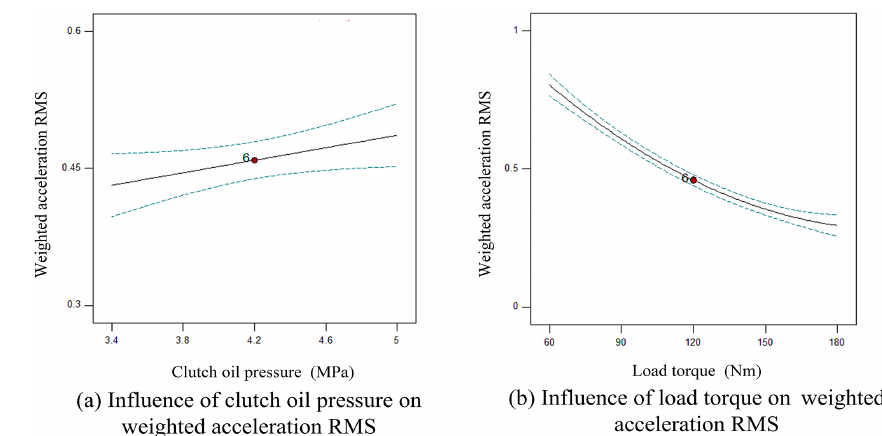
Figure 7. Single influencing factor analysis of weighted acceleration RMS.